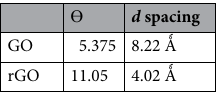
Table 1. D- spacing difference of GO and RGO.